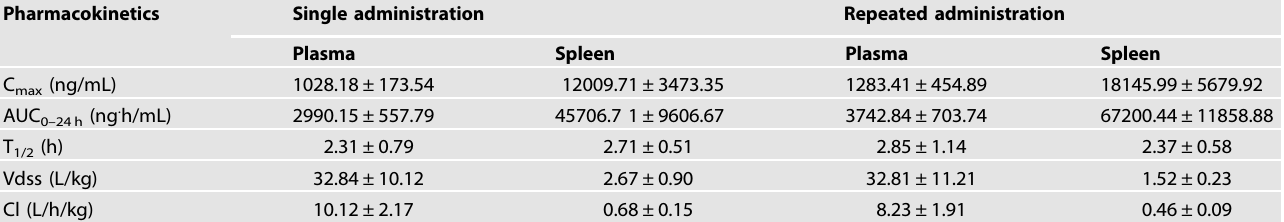
Table 1. Pharmacokinetic parameters of plasma and spleen in Ba/F3- EPOR - JAK2 V617F tumor-bearing mice after single or repeated oral administration of FM.